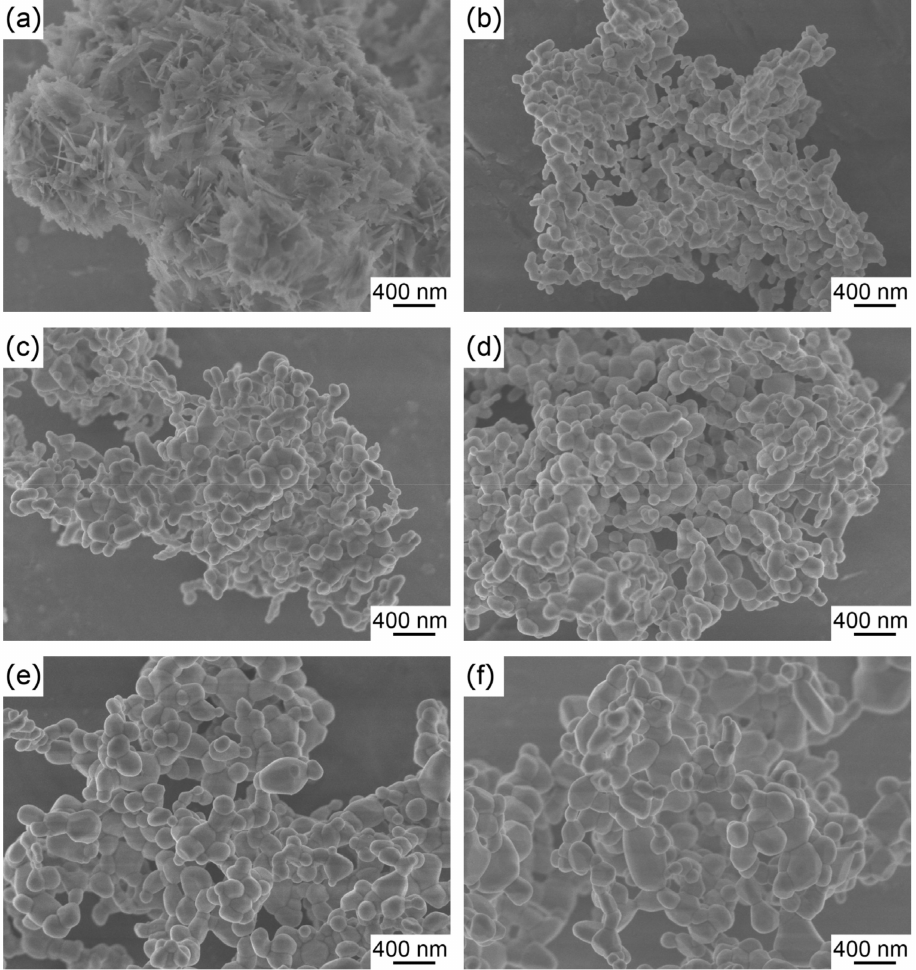
Figure 6. Field emission scanning electron microscopy (FE-SEM) pictures of the precursor ( a ) and the Dy 2 O 3 powders calcined at different temperatures: ( b ) 950 ◦ C, ( c ) 1000 ◦ C, ( d ) 1050 ◦ C, ( e ) 1100 ◦ C, ( f ) 1150 ◦ C.